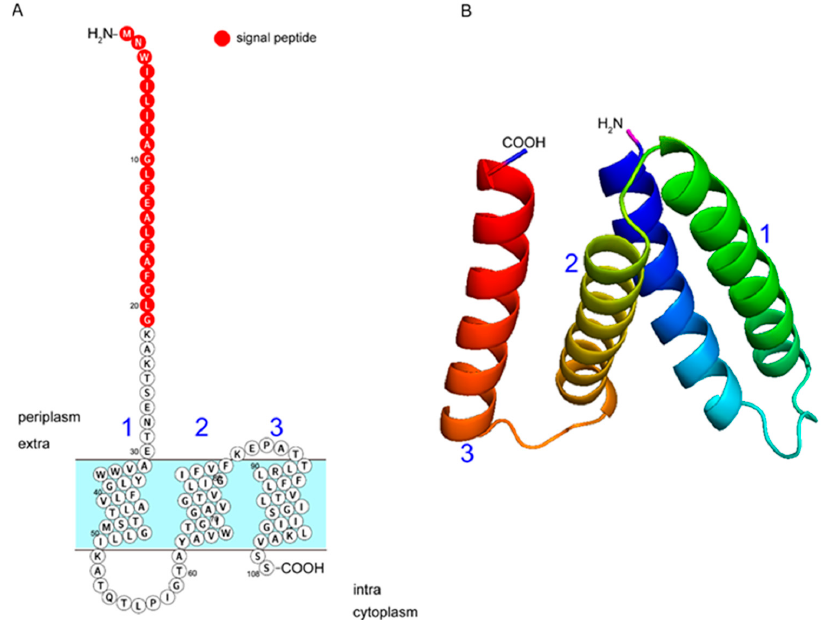
Figure 1. RanQ secondary structure and transmembrane topology. ( A ) Prediction of the structure of RanQ using Protter. The putative protein is shown parallel to the cytoplasmic membrane. ( B ) 3D representation of RanQ viewed along the plane of the membrane from the periplasmic side and visualized using the PyMOL 2.5 software. The 3 transmembrane α -helices are numbered (1 to 3); signal peptides are marked with red circles; and the N-termini is in the periplasm while the C-termini is in the cytoplasm.